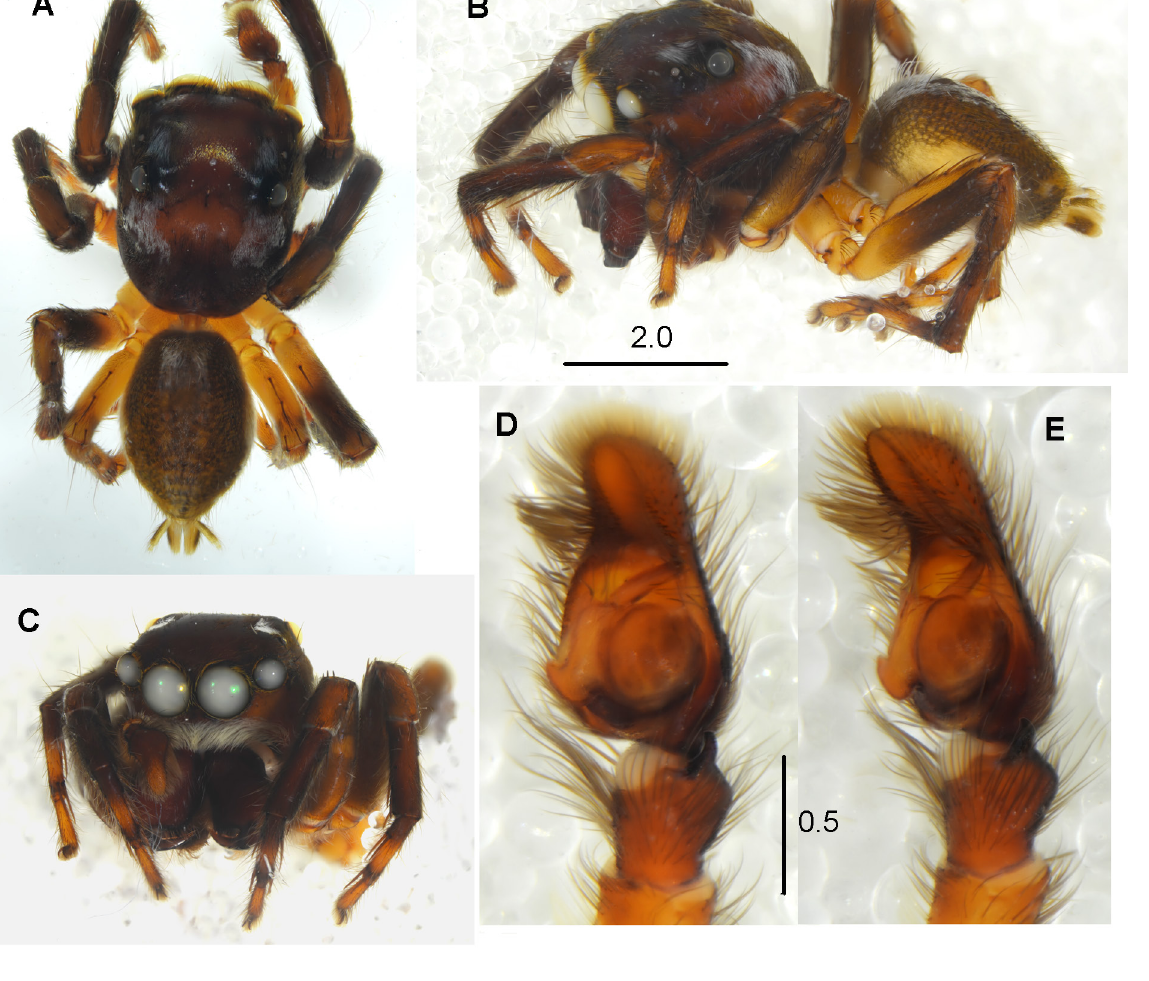
Fig. 66. Thiratoscirtus silvestris sp. nov., holotype, ♂ (MNHN). A . Habitus, dorsal view. B . Habitus, dorsolateral view. C . Frontal view. D–E . Palpal organ, ventrolateral